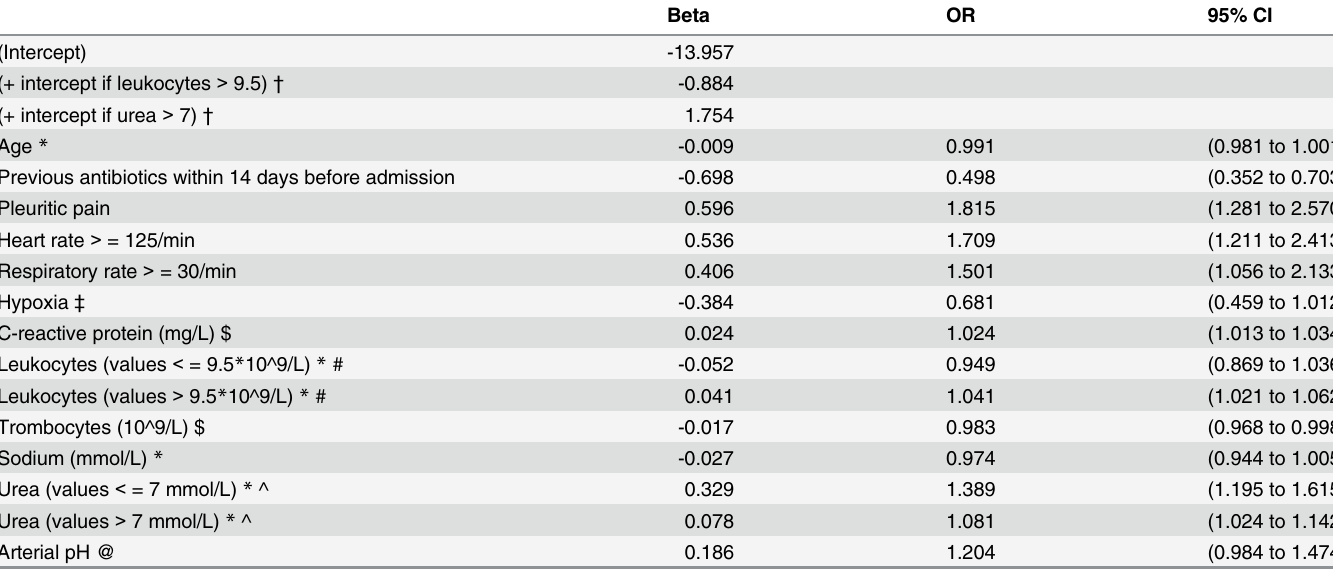
Table 4. Model including laboratory results of predictors independently associated with